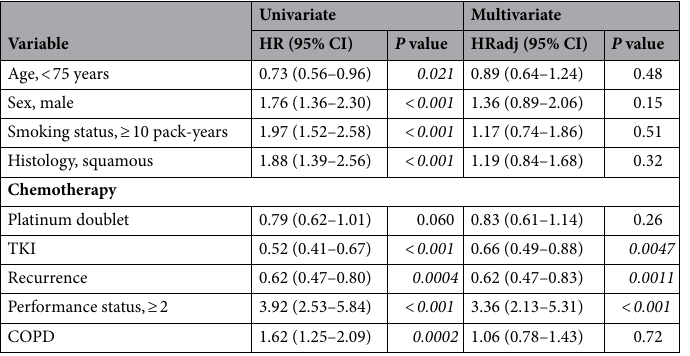
Table 2. Univariate and multivariate analyses of the association between various clinical characteristics and OS. Comparisons were made by means of chi-squared tests unless otherwise indicated. Significant values are in [italics]. TKI Tyrosine kinase